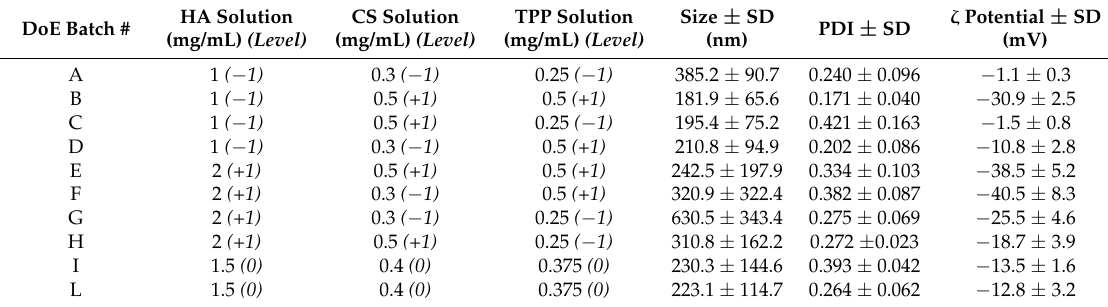
Table 1. Hyaluronic acid (HA), chitosan (CS), and pentasodium tripolyphosphate (TPP) solution concentrations (input variables) and HA/CS-TPP nanoparticles (NPs) sizes and ζ